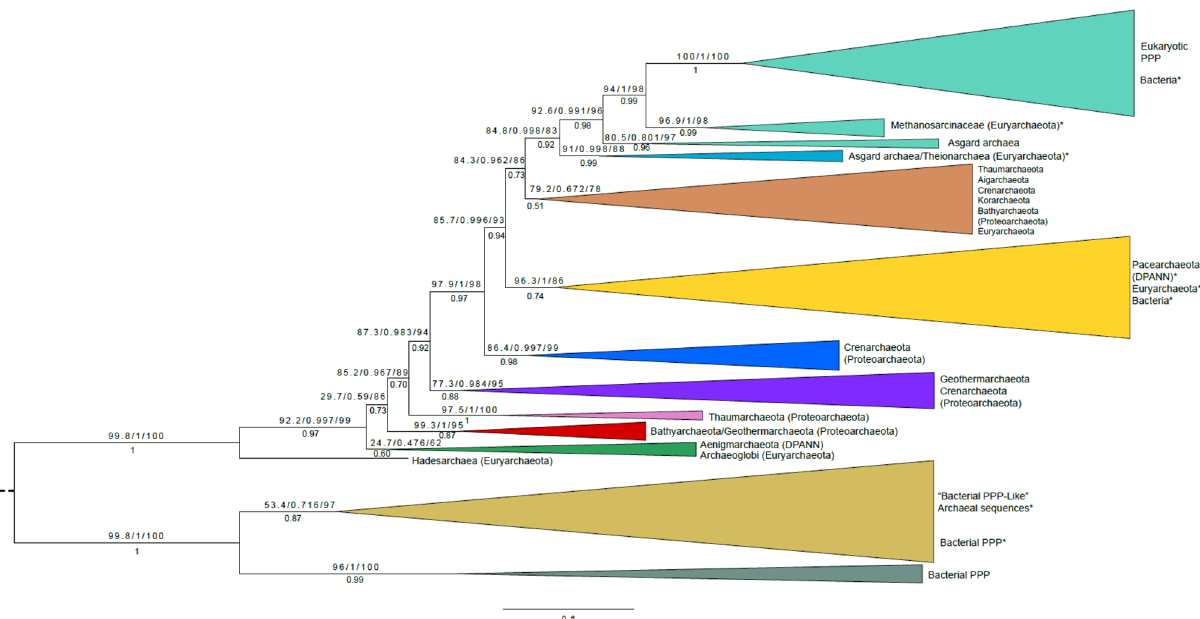
Figure 2. Evolution of PPP sequences in Archaea, Bacteria and Eukaryotes—simplified phylogenetic tree. Candidate PPP sequences were collected by Hidden Markov Model (HMM) based search methods, aligned, and phylogenetic trees inferred as detailed in “Methods”. Shown is a simplified representation of an orthogonal phylogram, with important sequence clusters depicted as cartoon branch expansions. The topology depicted is from the ML tree, but a virtually identical tree (identical in all shown branches) was obtained by Bayesian analysis. Support numbers above each branch represent the support in the ML tree (SH-aLRT/aBayes/UFBoot) (see “Methods”), whereas numbers below each branch represent the posterior probability in the Bayesian tree. The trees were inferred as unrooted, but the root (dashed line) was placed by separate BEAST analysis (data not shown). A detailed orthogonal phylogram is presented as Supplemental Figure S7, and a radial phylogram is presented as Fig. 3. In the trees, individual sequences or groups whose placement is likely to be due to lateral gene transfer (LGT) (see Text) have an asterisk. The alignment giving rise to these trees is presented as Supplemental Figure S6. The component candidate sequences are summarized in Supplemental Table S1 (archaeal candidates, “BacterialPPP-Like”), Supplemental Table S2 (archaeal candidates, “EukaryoticPPP-Like”), and Supplemental Table S3 (bacterial candidates, “EukaryoticPPP-Like” archaeal sequences, and “EukaryoticPPP-Like” bacterial sequences (Supplemental Fig- ure S5). As expected, the set of six sequence motifs (labeled) is conserved. The Arg residue in Motif 2 (down